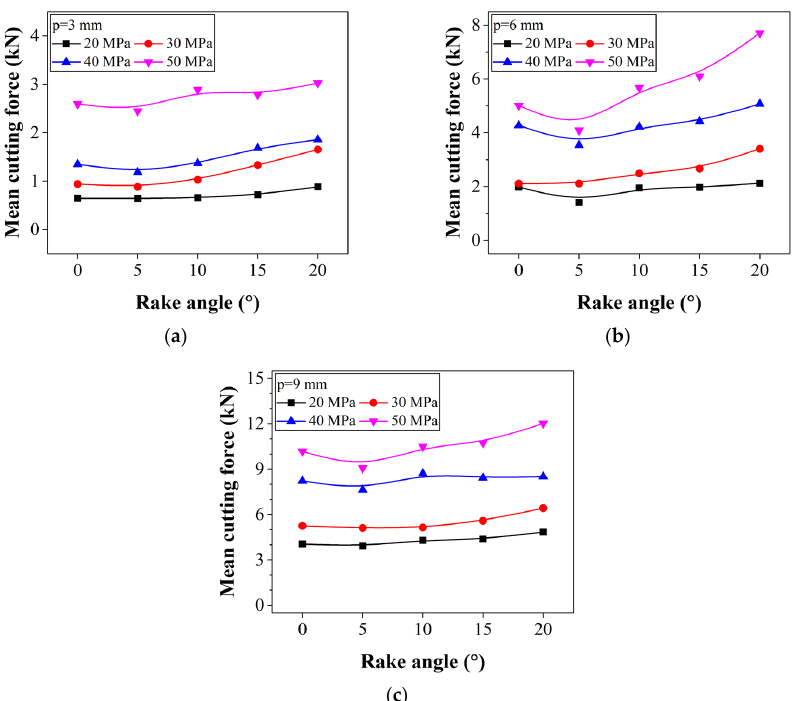
Figure 11. Relationship between the mean cutting force and rake angle at cutting depths ( p ) of: ( a ) 3 mm, ( b ) 6 mm, and ( c ) 9 mm.